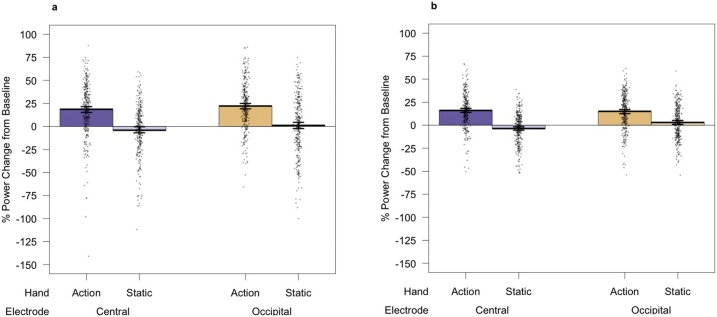
Mean percentage change in power from baseline for static hand observation and hand action observation over the central and occipital electrodes in alpha (a) and beta (b) bands. The bold horizontal line indicates the group mean and the bars indicate the 95% confidence intervals. The points show the raw data. Positive values indicate alpha and beta desynchronization and negative values indicate alpha and beta synchronization.